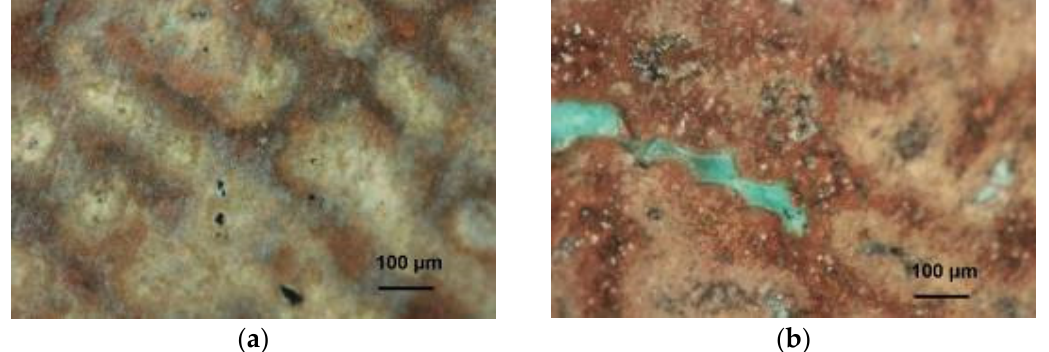
Figure 4. OM images (×100) of the corrosion patterns observed at the segregated surface of TB castings after the end of anodic sweeps in 0.6 mol/L NaCl: ( a ) corroded dendritic structure and ( b ) Cu(II) corrosion products formation inside voids —These features are encountered near the electrode edge.